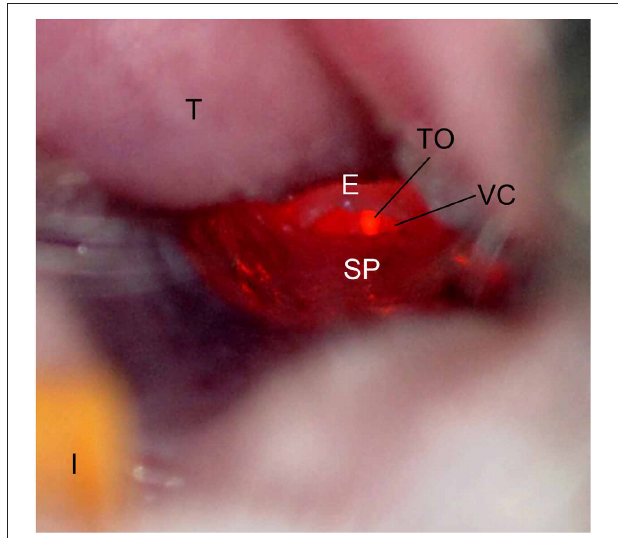
FIGURE 2 | Mouse oropharynx anatomy. The mouse in the supine position with the incisors (I) at the bottom and the tongue (T) located at the top of the figure. The tracheal opening (TO), epiglottis (E), vocal chords (VC), and soft palate (SP) are